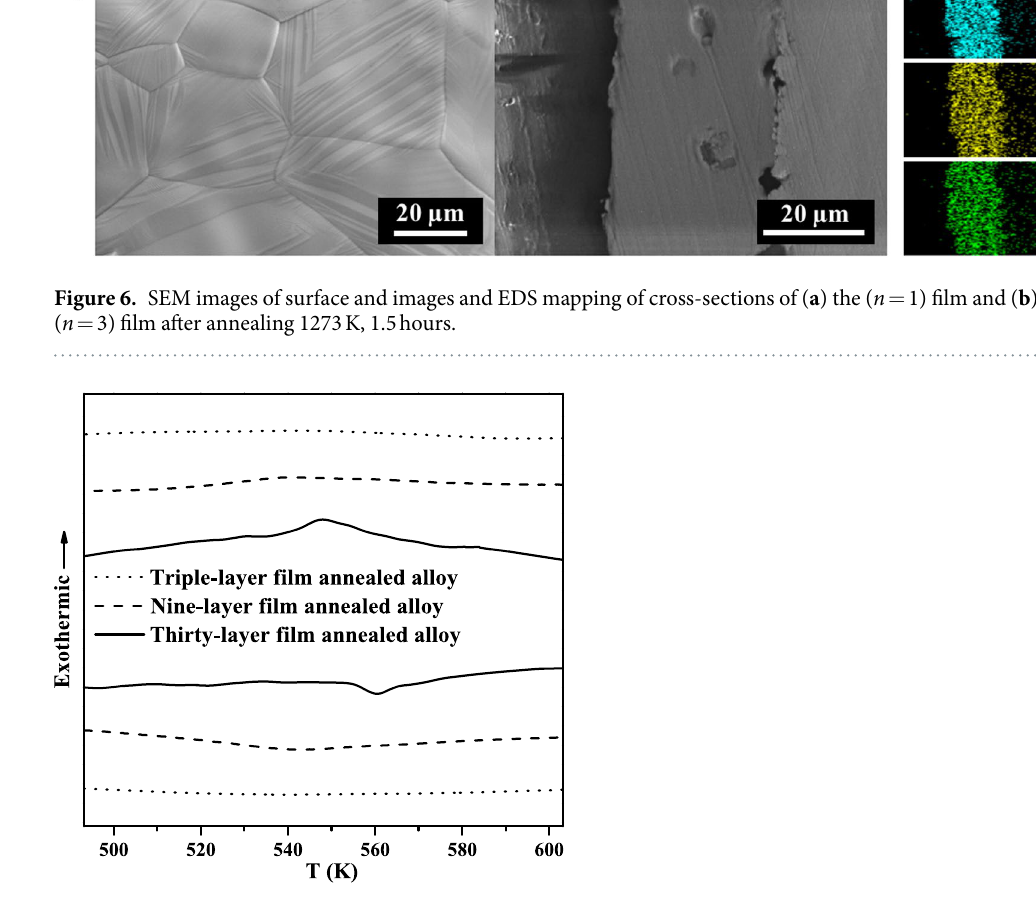
Figure 7. The DSC measurements of triple-layer ( n = 1, 1.0 μ m), nine-layer ( n = 3, 8.7 μ m), and thirty-layer ( n = 10, 28.9 μ m) film annealed alloys (Ni 0.50 Mn 0.419 Sn 0.081